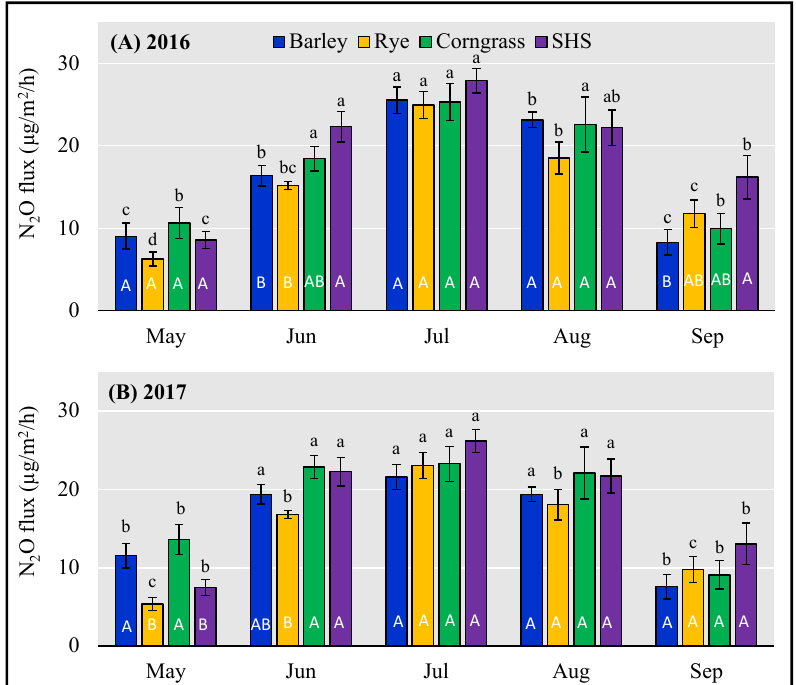
Figure 2. The dynamics of soil N 2 O emission in 2016 ( A ) and 2017 ( B ) in barley, rye, sorghum hybrid sudangrass (SHS), and corngrass fields. For each species, means with the same lowercase letters are not significantly di ff erent between di ff erent months ( P > 0.05); for each month, means with the same uppercase letters are not significantly di ff erent between di ff erent grass species ( P >